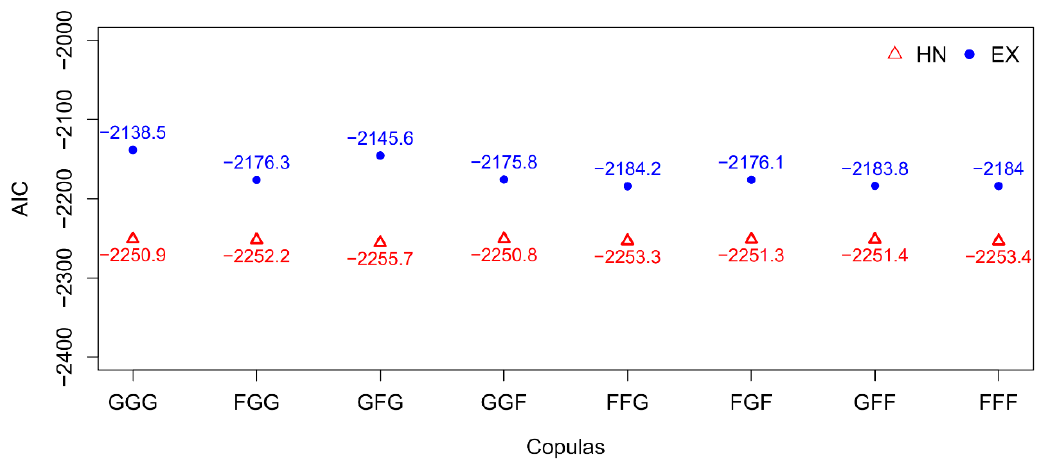
Figure 3. AIC values for each copula-based simultaneous SFM (the symbol “G” stands for “Gaussian copula”; “F” represents “Frank copula”; and “HN” and “EX” represent half-normal and exponential distributions, respectively. The three copulas are listed, according to the order of the dependence between v 1 and w 1 , v 2 and w 2 , and ε 1 and ε 2 ).